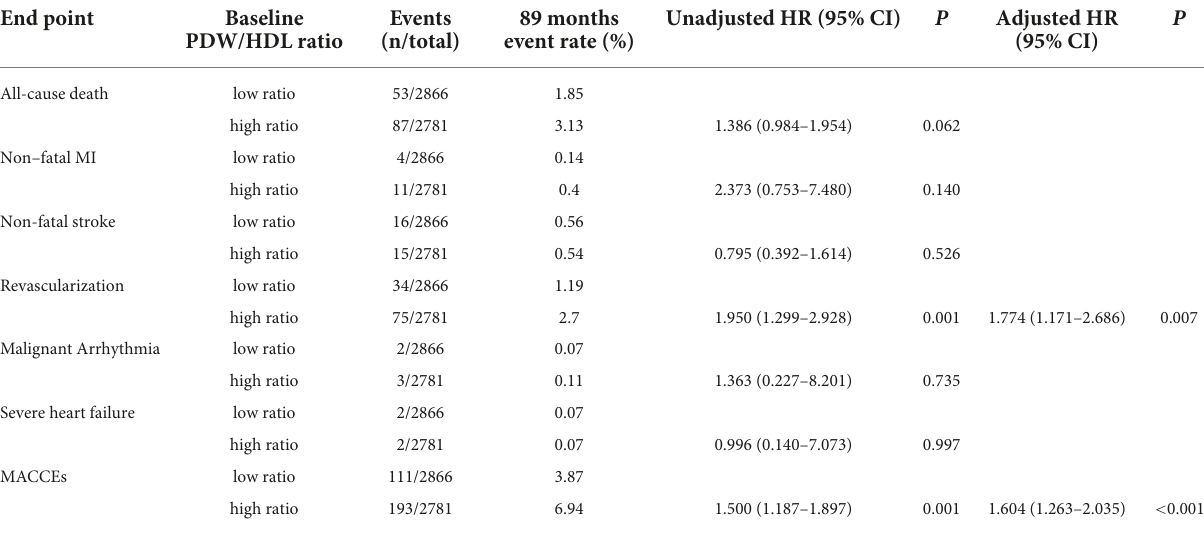
TABLE 4 Baseline PDW/HDL ratio and prediction of